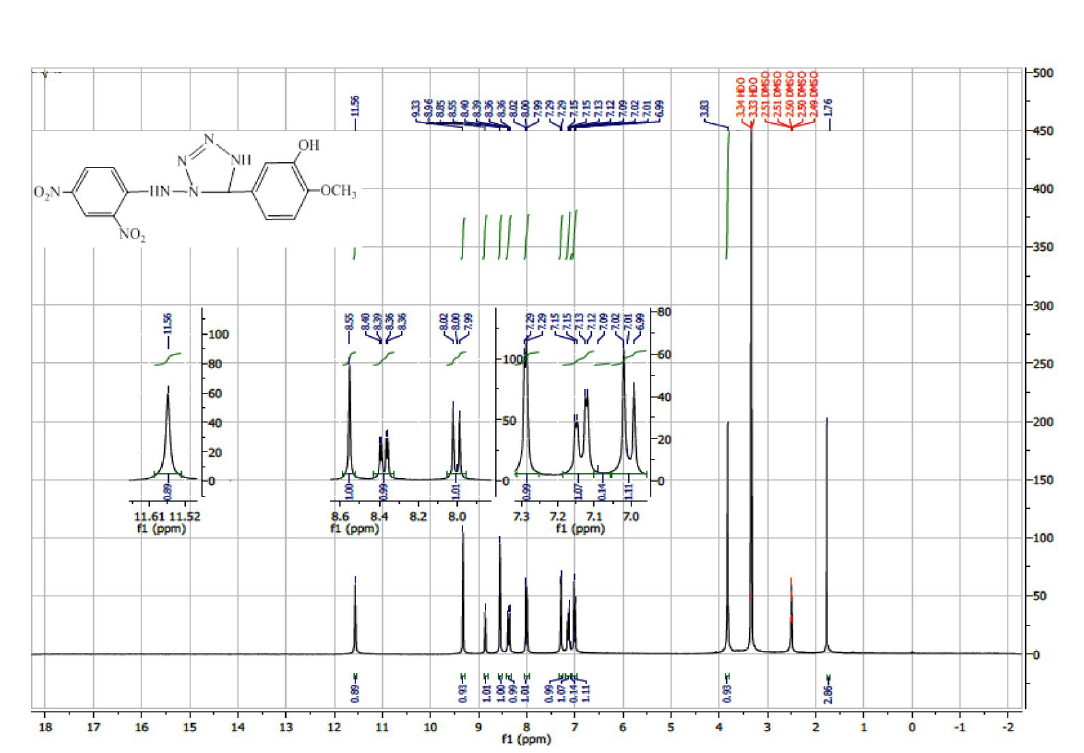
Figure 1. 1 H NMR Spectrum of I